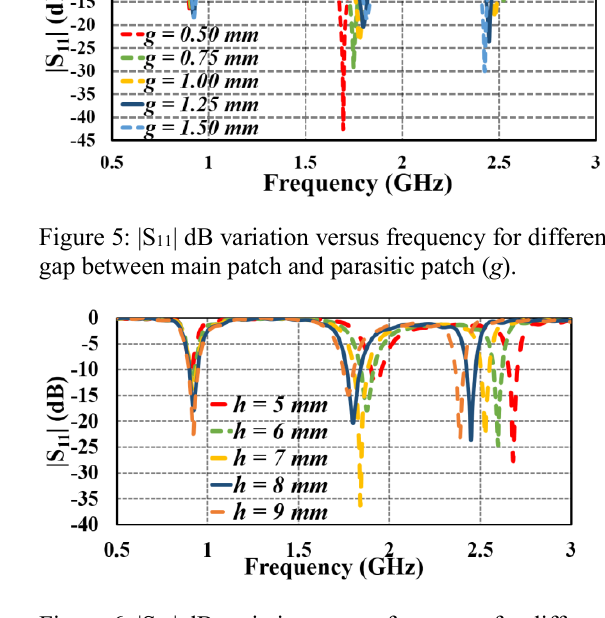
Figure 6: |S 11 | dB variation versus frequency for different antenna height ( h ).